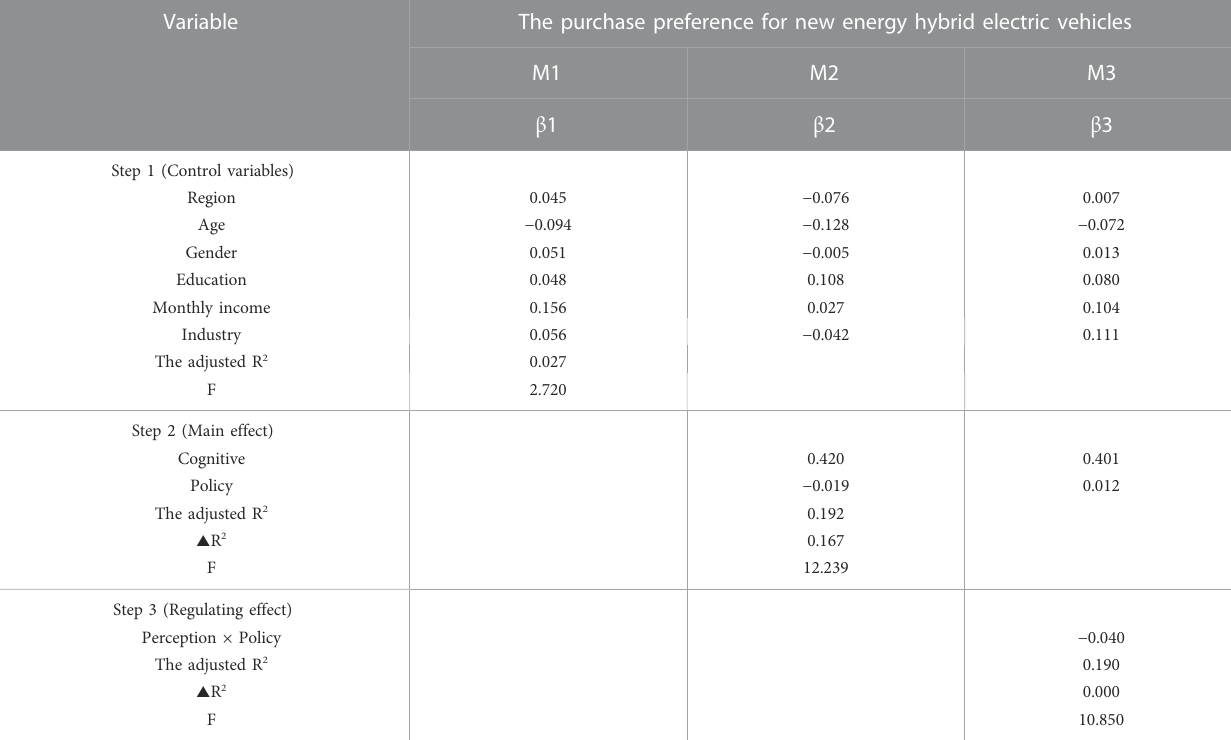
TABLE 12 Regression analysis of consumers ’ perception of the regulatory role of the government ’ s new energy vehicle policy.